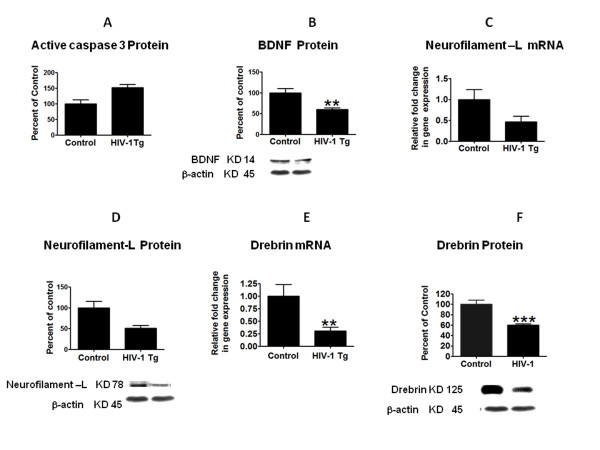
(A) Representative brain active caspase-3 level in control and HIV-1 Tg rats. The active caspase-3 level was measured in brain cytosolic fractions as described in Methods. Bar graphs are relative to control and were compared using an unpaired t-test, mean ± SEM. Representative immunoblots of BDNF (B), neurofilament-L (D) and drebrin (F) protein levels in control and HIV-1 Tg rats. Bar graphs display mean ± SEM optical densities of individual protein bands relative to β-actin, expressed as percent of control. mRNA levels of neurofilament-L (C) and drebrin (E) in control and HIV-1 Tg rat brain, measured using real time TaqMan RT-PCR. Data represent mean ± SEM mRNA levels in the HIV-1 Tg rat brain normalized to β-globulin, relative to control level (calibrator) using the ΔΔCT method. statistical significance: **p < 0.01, ***p < 0.001 as determined by an unpaired t-test.